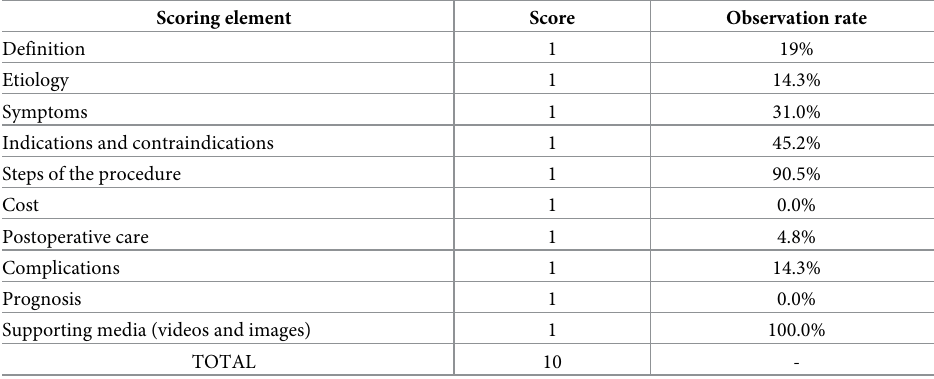
The interactions of users with the included videos were assessed based on the interaction index and the viewing rate by using the formulae: [(number of likes-number of dislikes/ total number of views) � 100%)] and [(number of views/ number of days since upload) � 100%)],